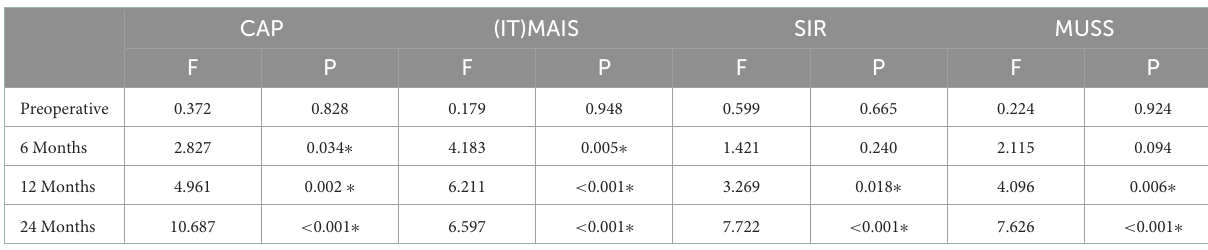
TABLE 3 Analysis of variance results of four scales at each time